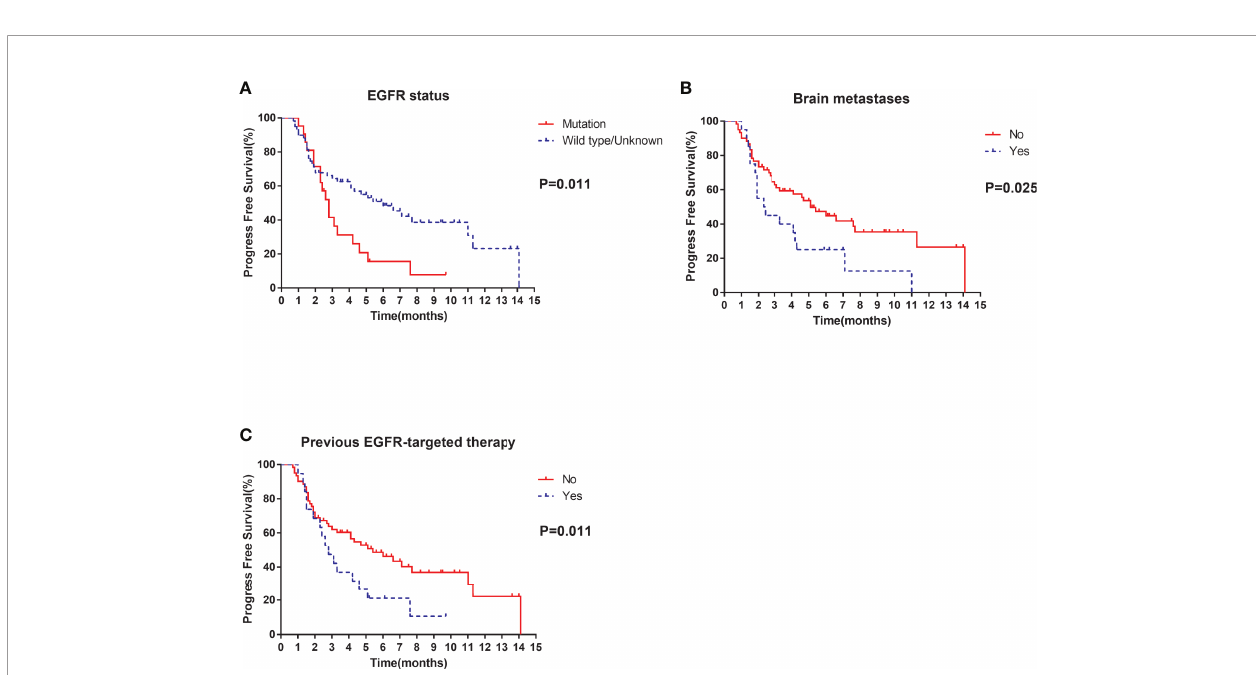
TABLE 2 | Cox regression analysis of factors associated with progression-free survival in the entire sample. Factor p value HR HR95%CI EGFR status